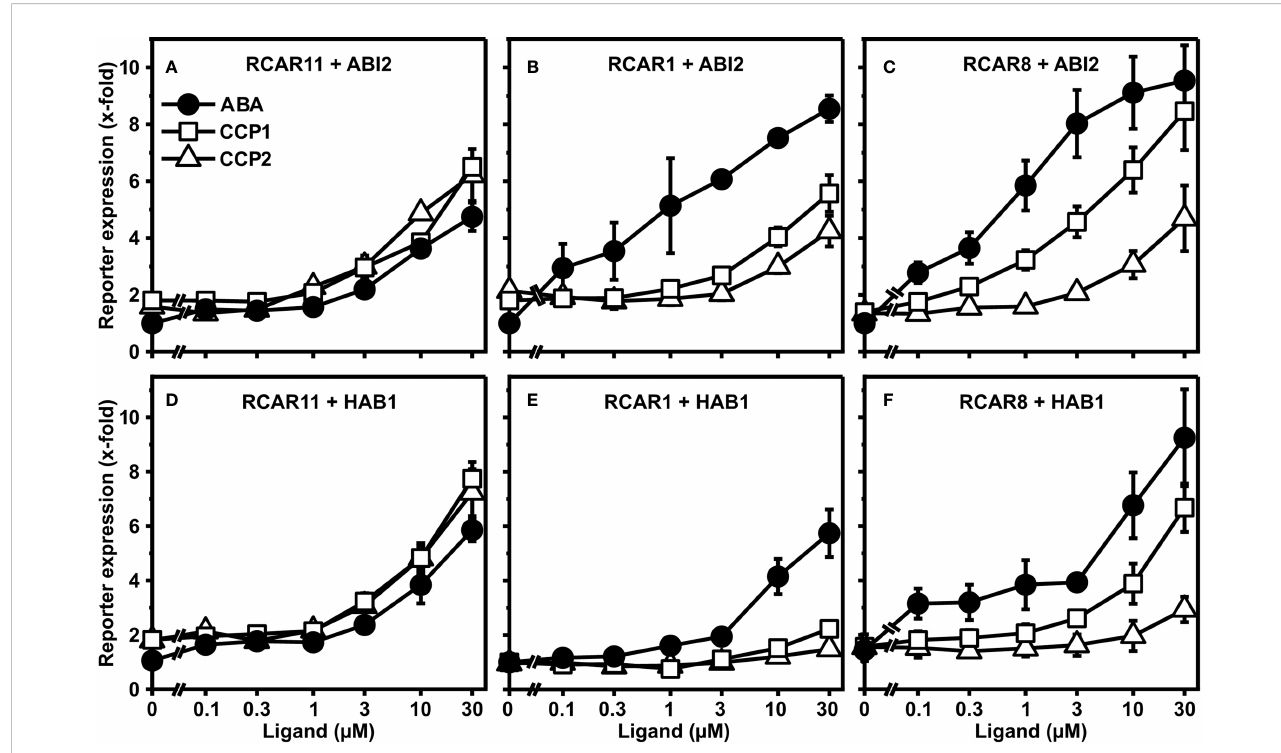
FIGURE 2 Receptor complex-dependent activation of ABA signaling by ABA, CCP1, and CCP2 in yeast. ABA- ( fi lled circles), CCP1- (open squares) and CCP2- (open triangles) dependent regulation of ABI2 by RCAR11 (A) , RCAR1 (B) , and RCAR8 (C) . CCP1- and CCP2-dependent regulation of HAB1 by RCAR11 (D) , RCAR1 (E) , and RCAR8 (F) . n = 3 biological replicates, mean ± SEM. Statistical signi fi cance is given in Supplementary Tables 1,